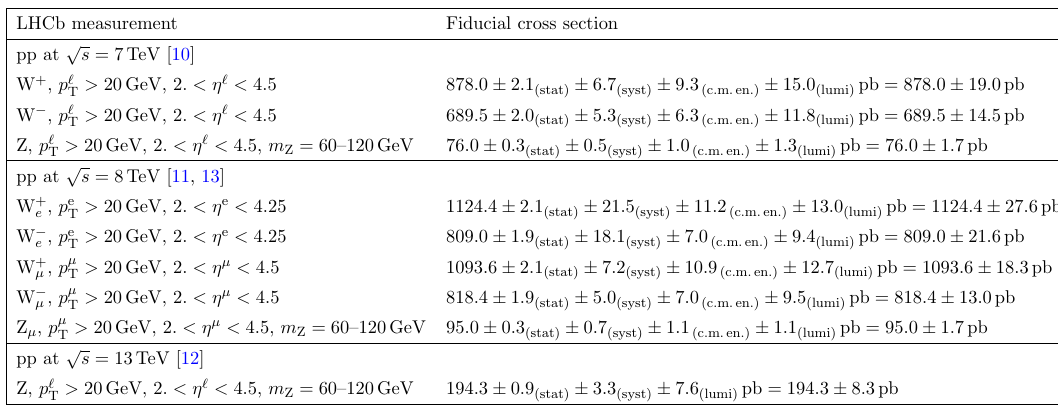
Table 2 . Compilation of the nine LHCb measurements of inclusive W (cid:6) and Z boson production p cross sections in pp collisions at s = 7, 8, 13 TeV [10{13], in combined leptonic (W (cid:6) , Z), electron